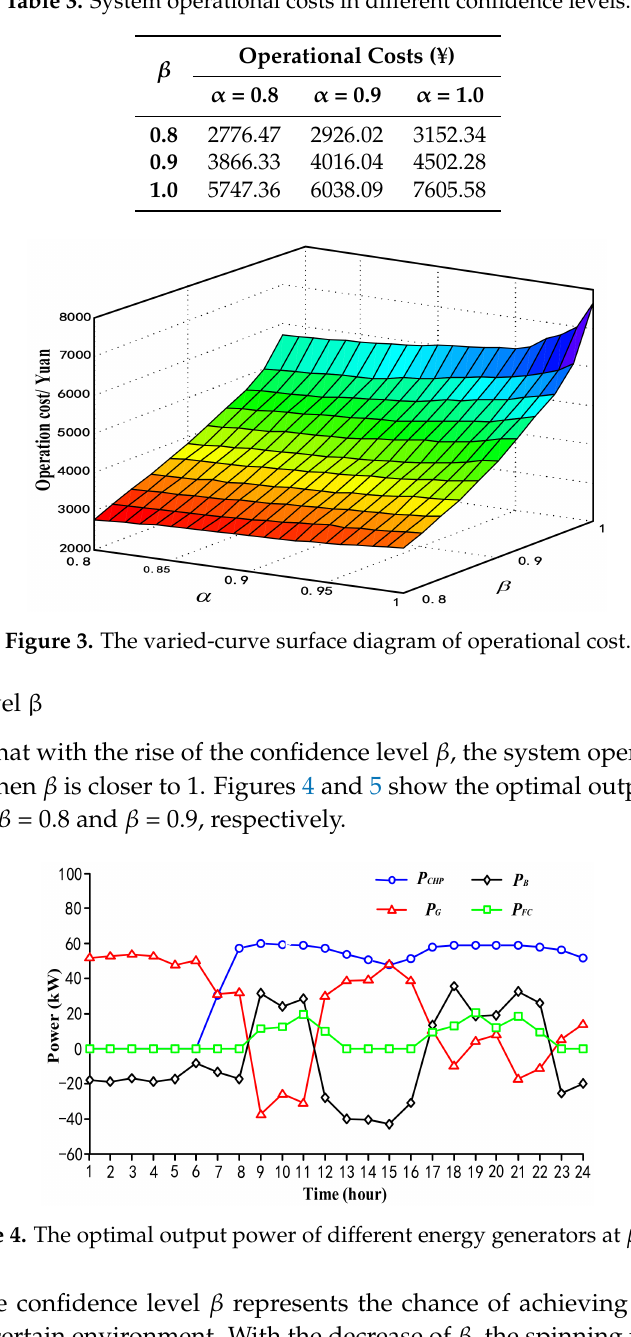
Table 3. System operational costs in different confidence levels.